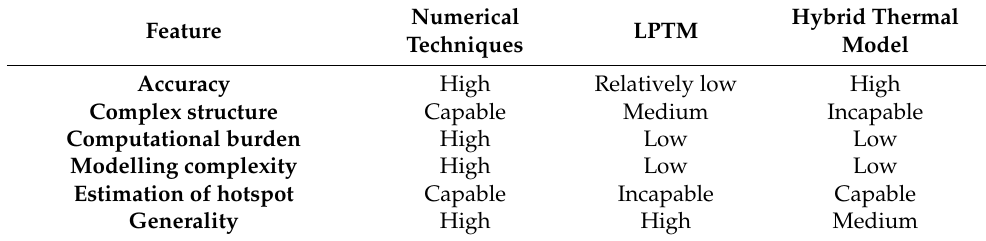
Figure 30. Comparison of main thermal analysis methods. Table 8. Evaluation of main thermal analysis methods.